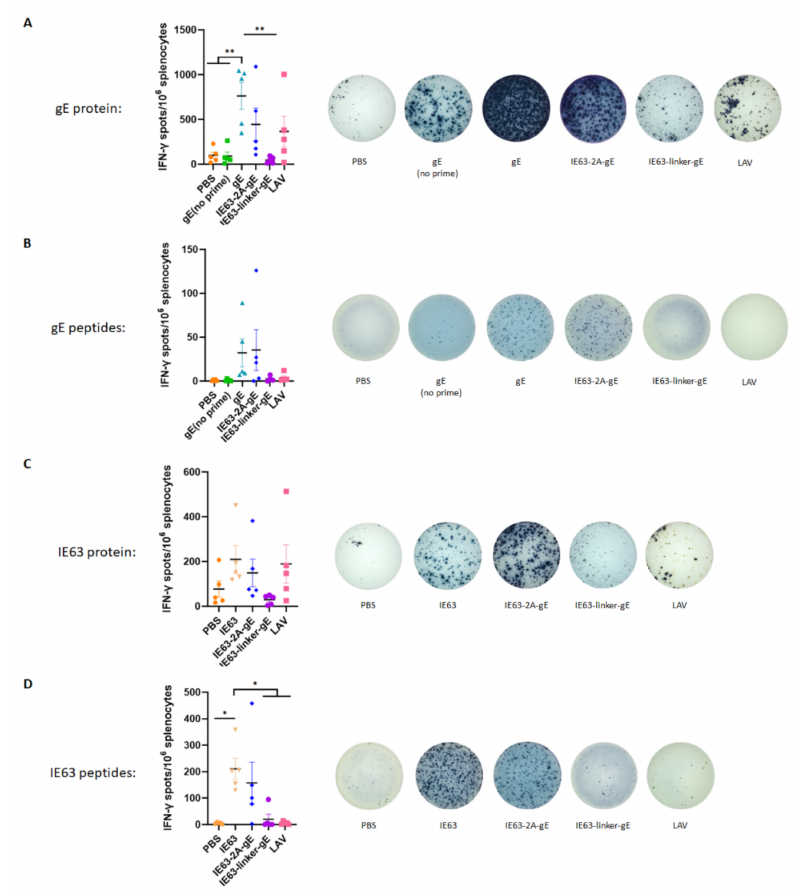
Figure 3. IFN- γ secreting cell frequencies in immunized mouse splenocytes. Frequencies of antigen- specific IFN- γ secreting cells were assayed via IFN- γ ELISPOT using freshly isolated splenocytes on day 42. The cells were stimulated with 5 µ g/mL gE protein ( A ), IE63 protein ( C ) or 10 µ g/mL gE peptides ( B ), IE63 peptides ( D ) for 24 h. The y axis shows the spot forming cells (SFCs) among 10 6 splenocytes. Representative raw ELISPOT data were presented. * p < 0.05; ** p < 0.01. Data represent mean ± SEM ( n =